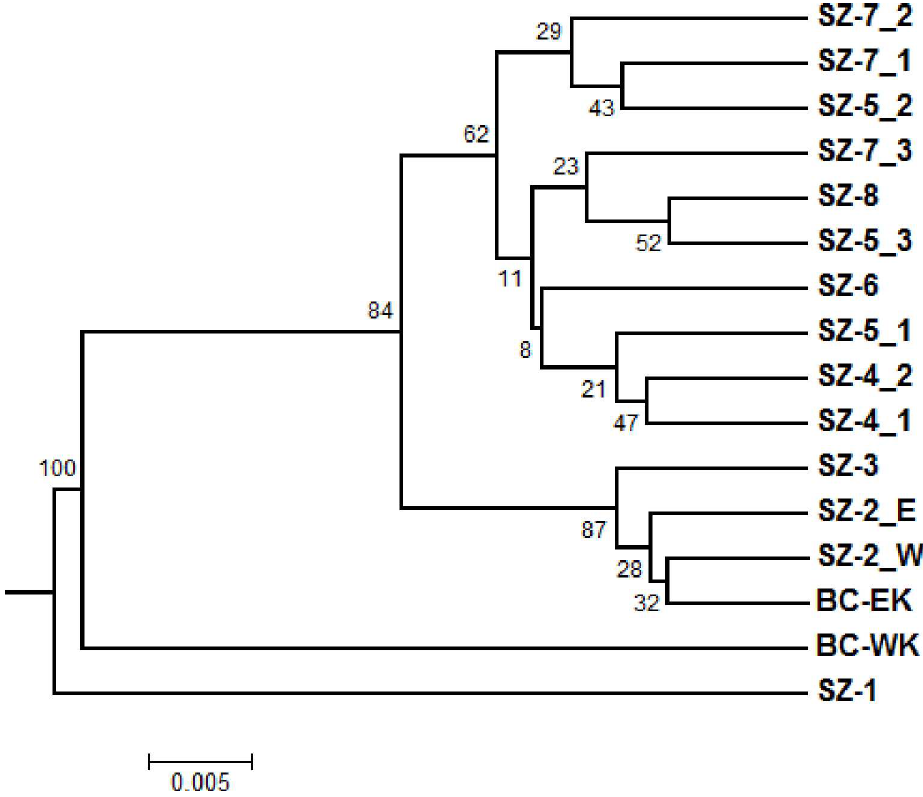
Fig 4. Phylogenetic relationships among whitebark pine populations. Nei’s standardgenetic distances with sample size correction (Dst) (Nei 1972) were calculatedusing genotypicdata of 71 SNP loci. A consensus dendrogram was constructed using the unweighted pair-group method with arithmetic mean (UPGMA). Bootstrap values are indicatedon the nodes as percentagesas tested with 1000bootstrap